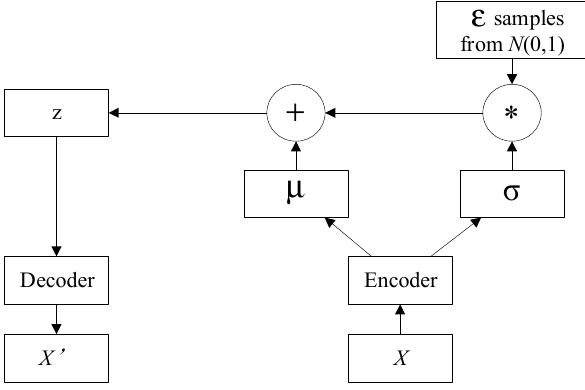
Figure 2. The encoding and decoding process of the VAE.